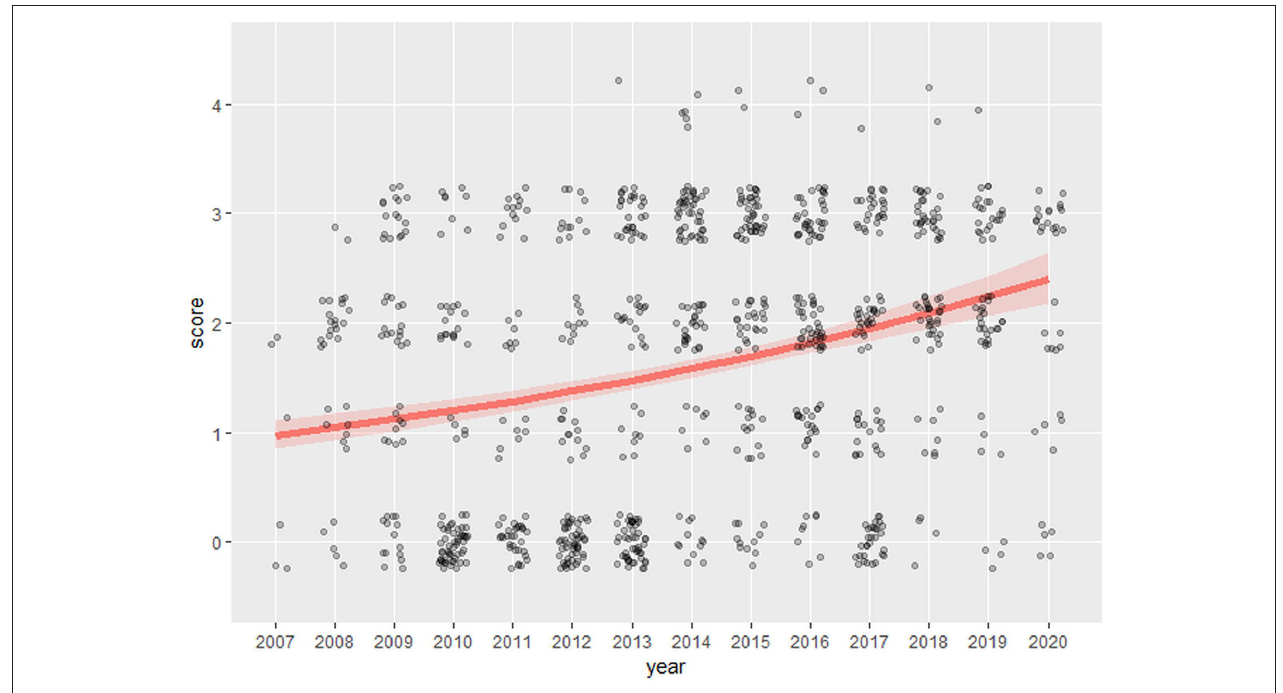
FIGURE 2 | Effect plot negative binomial regression for [pimp POSS